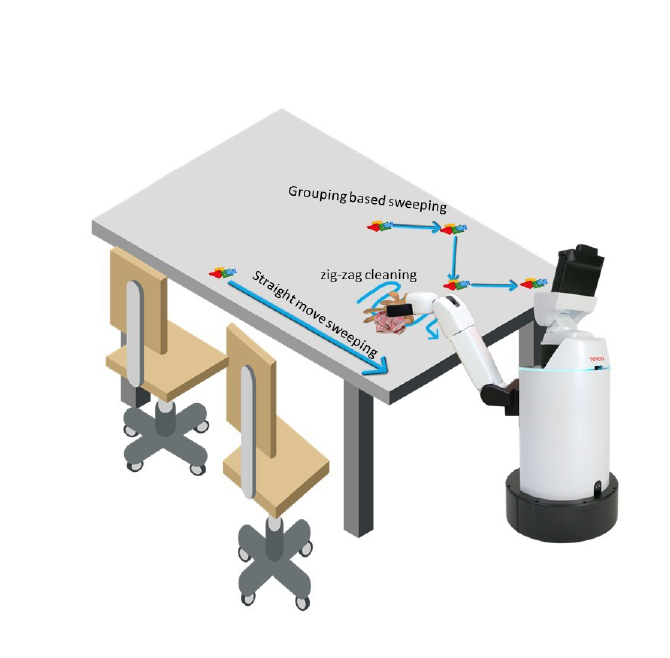
Figure 4. Planned Cleaning